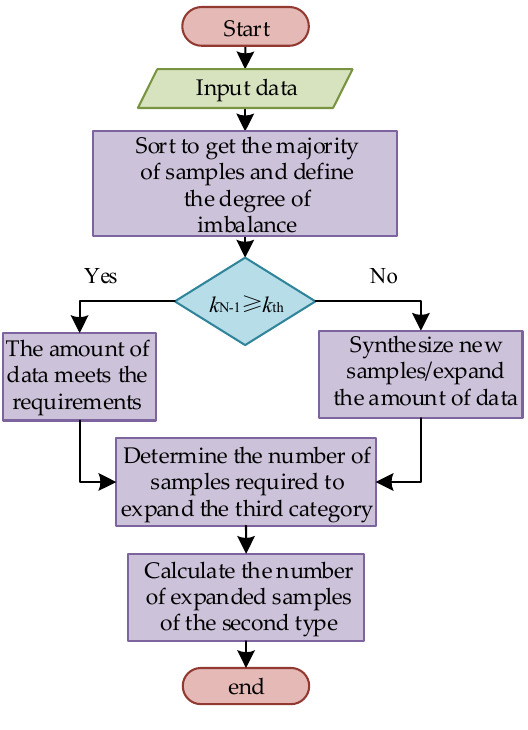
Figure 3. Flow chart of the improved adaptive synthetic sampling algorithm.